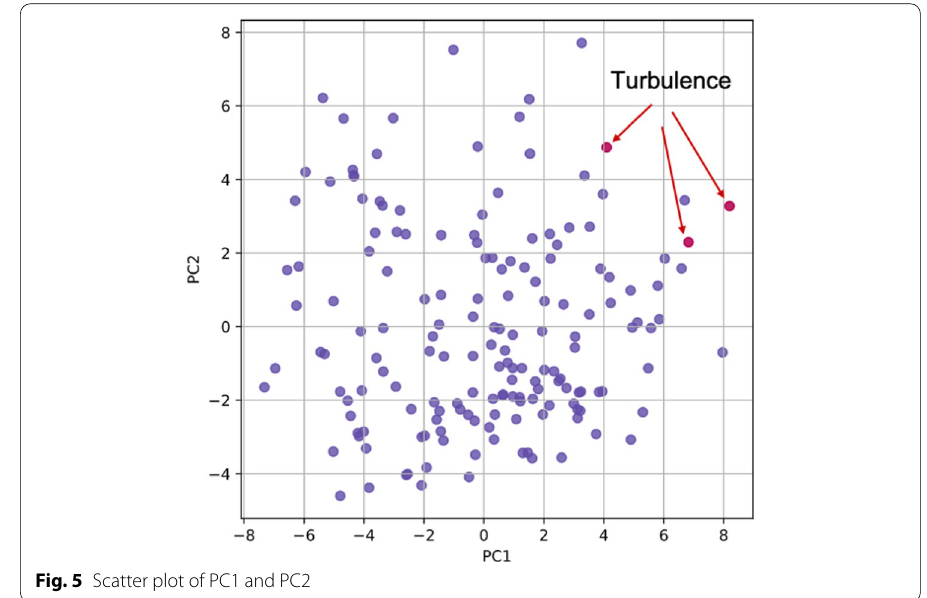
Fig. 5 Scatter plot of PC1 and PC2